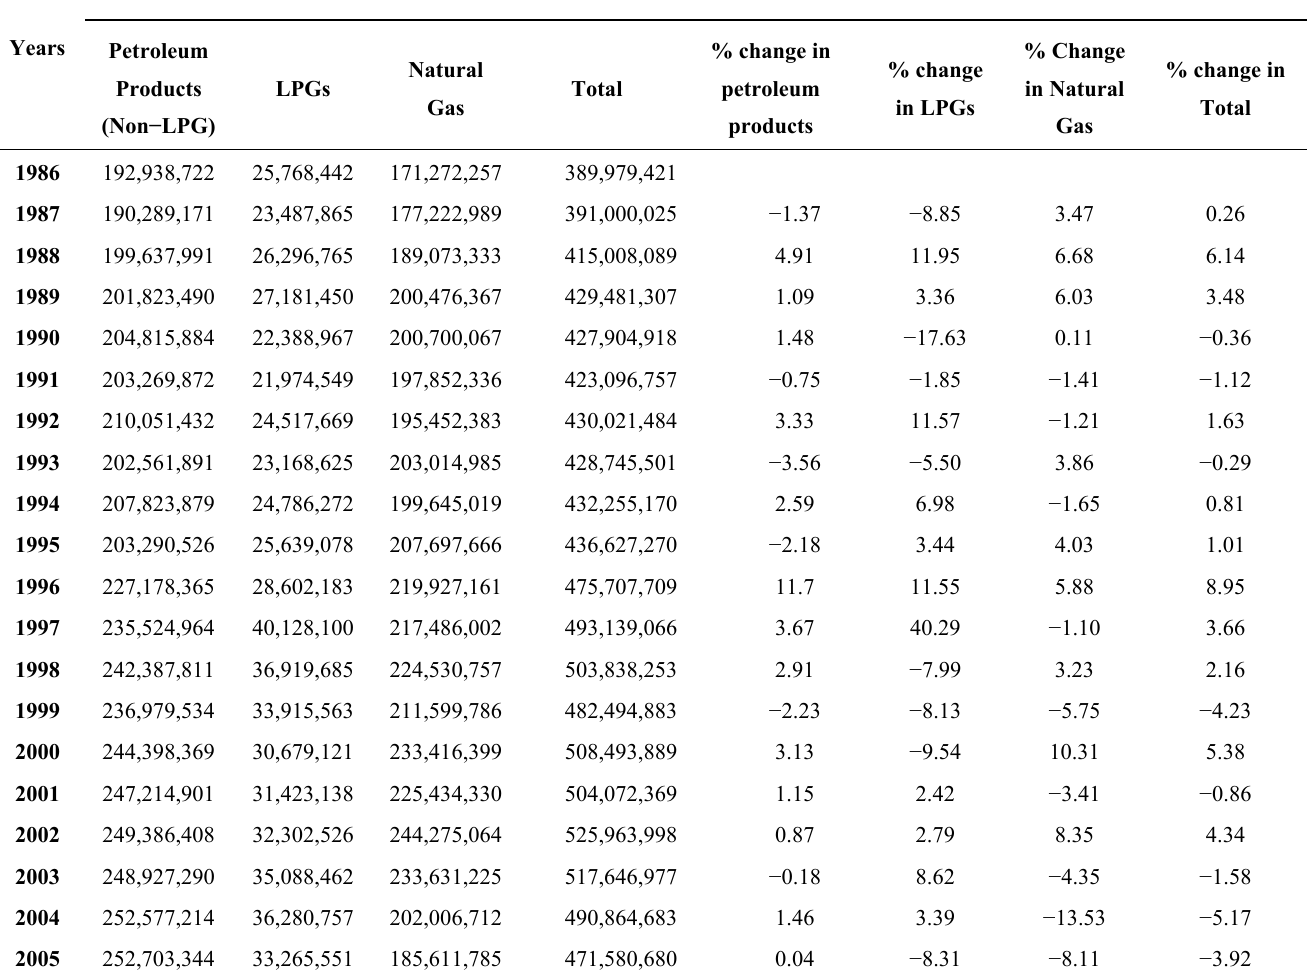
Table 4. Temporal Distribution of Petroleum Sources of Carbon Dioxide Emissions and Percentage of